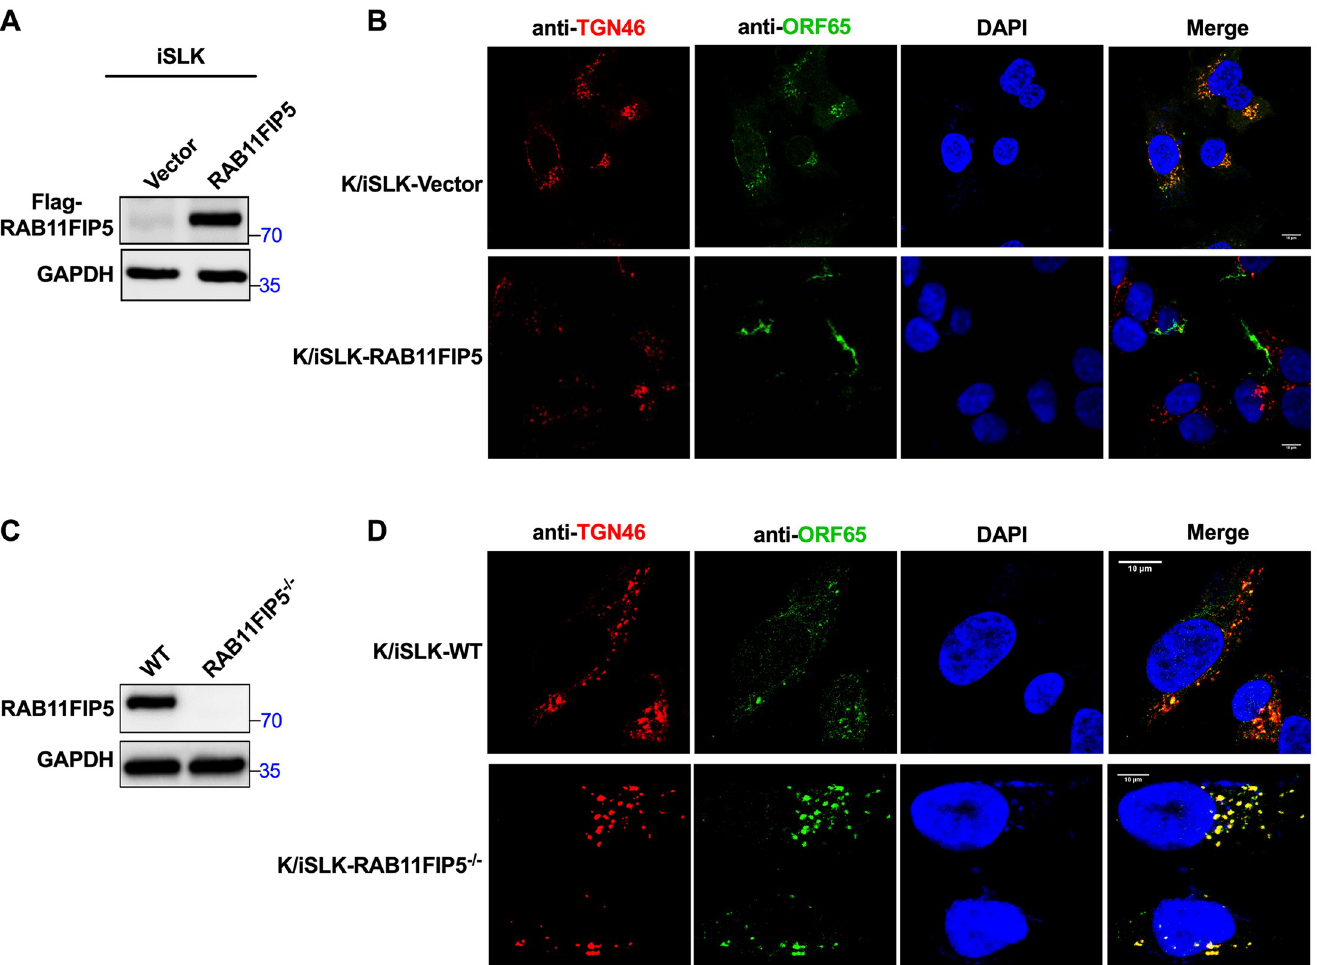
Fig 8. RAB11FIP5 impairs the translocation of KSHV particles to the trans-Golgi network. Stable clones of iSLK-Vector, iSLK-RAB11FIP5, iSLK-WT and iSLK-RAB11FIP5 -/- cells were isolated and expended from the monoclonal cell population by the limiting dilution method (A and C). These cells were infected with stock KSHV isolated from BCBL1 cells. Seventy-two hours after infection, latency was established; we designated the corresponding infected cells K/iSLK-Vector, K/iSLK-RAB11FIP5, K/iSLK-WT and K/iSLK-RAB11FIP5 -/- cells. (B) K/iSLK-Vector and K/iSLK-RAB11FIP5 cells were induced with dox to stimulate lytic KSHV replication. Viral particles were labeled with the mouse anti-ORF65 antibody, while the trans-Golgi network was labeled with the rabbit anti-TGN46 antibody. FITC- and Cy3-conjugated secondary antibodies were used to visualize the labeled ORF65 and TGN46 proteins, respectively. (D) K/iSLK-WT and K/iSLK-RAB11FIP5 -/- cells were induced with dox to stimulate lytic KSHV replication. Viral particles were labeled with the mouse anti-ORF65 antibody, while the trans-Golgi network was labeled with the rabbit anti-TGN46 antibody. FITC- and Cy3-conjugated secondary antibodies were used to visualize the labeled ORF65 and TGN46 proteins,